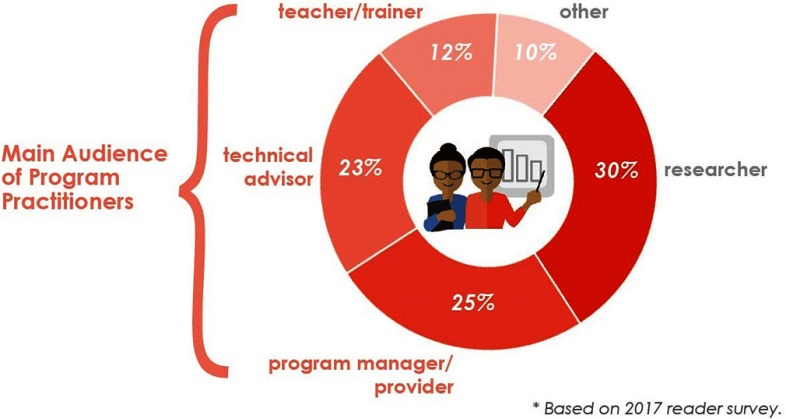
Job Function of GHSP ReadersSource: “Celebrating 5 Years of Success” infographic: http://www.ghspjournal.org/5year-anniversary.